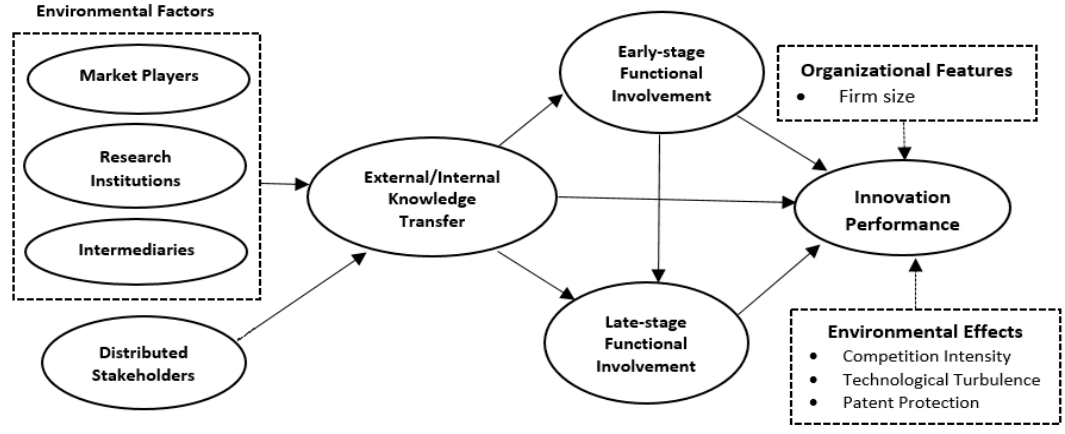
Figure2. Multi-mediationframeworkforthee ff ectoffunctionalinvolvementindistributedcollaborative Figure 2. Multi-mediation framework for the effect of functional involvement in distributed product development, adapted from Pateli and Lioukas collaborative product development, adapted from Pateli and Lioukas [8].